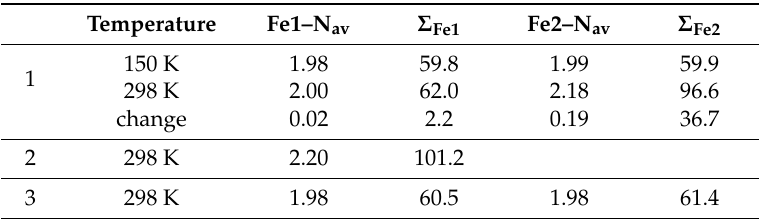
Table 3. Average Bond Length (Å), Octahedral Distortion Parameter Σ (o), and Parameters of Fe-N Bond of Compounds 1 – 3 under Different Temperatures.